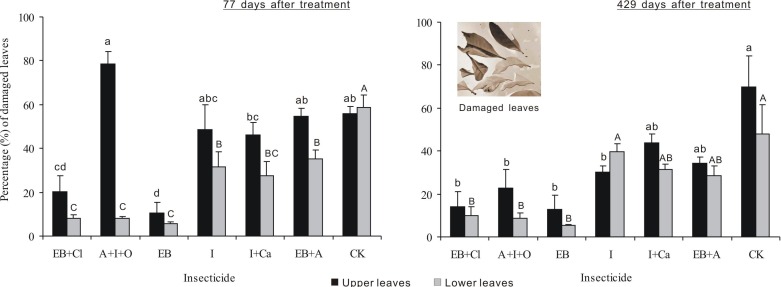
 Percentage of damaged leaves.Mean (± SE) percentage of damaged leaves collected from upper and lower canopies after the application of six types of trunk injection at 77 and 429 days. N = 42 isolated branches in each observation time. 77 days after treatment, insecticides, leaf position, and insecticides leaf position interaction effects were significant (P < 0.001); 429 days after treatment, insecticides effect was significant (P < 0.001), and leaf position and insecticides × leaf position interaction effects were not significant. Bars labeled with different lowercase or uppercase letters are significantly different at P = 0.05 from each other in the same leaf layer group (upper or lower leaves) based on Dunn’s range test.